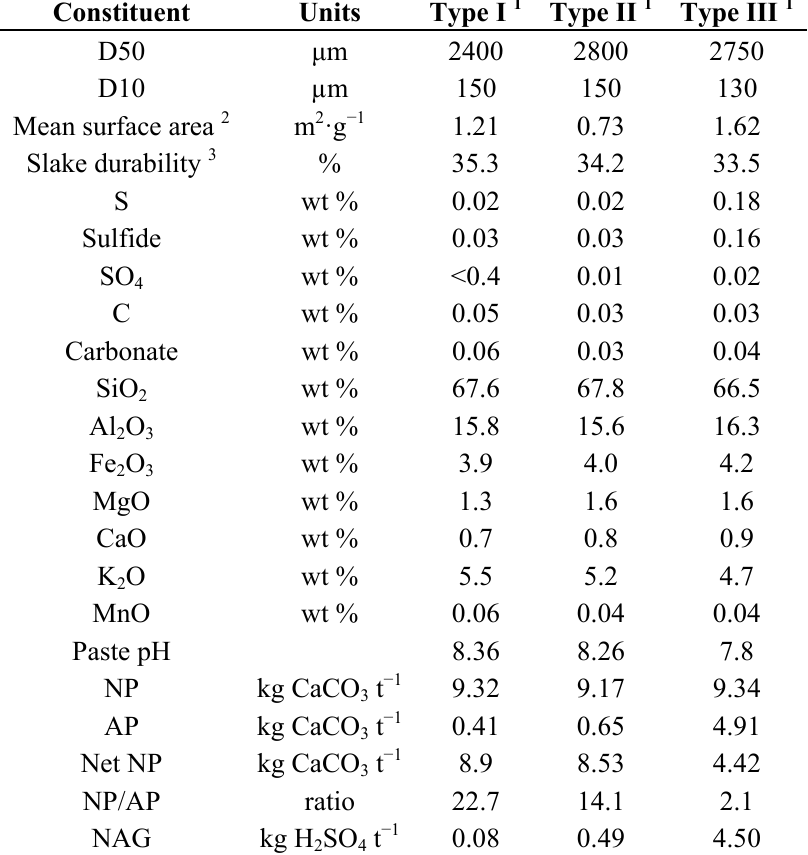
Table 1. Grain characteristics, metal oxide concentrations, and acid-base accounting results for run-of-mine samples collected in 2004 from Diavik Diamond Mine, Northwest Territories, Canada: D50, median particle size; D10, particle size at which 10% of the grains are smaller; Slake durability, average slake durability index for <6.3-mm particles; NP, neutralization potential; AP, acid generation potential; NAG, net acid